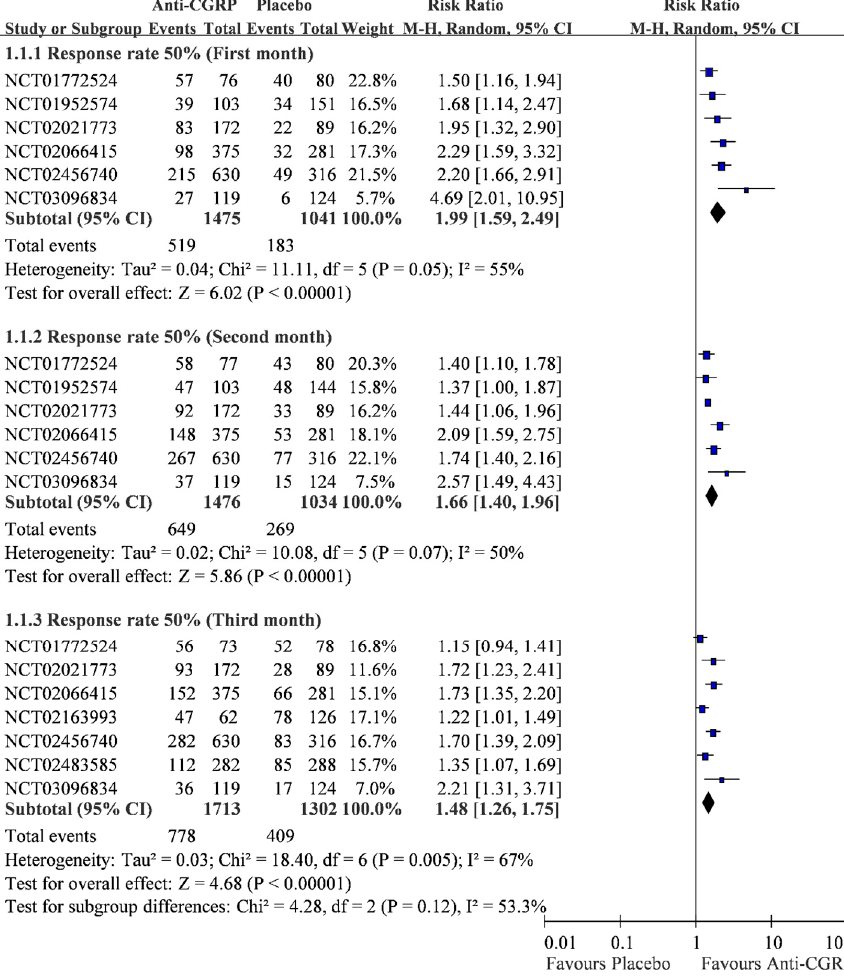
Figure 2. The 50% reduction rate of anti-CGRP and placebo.